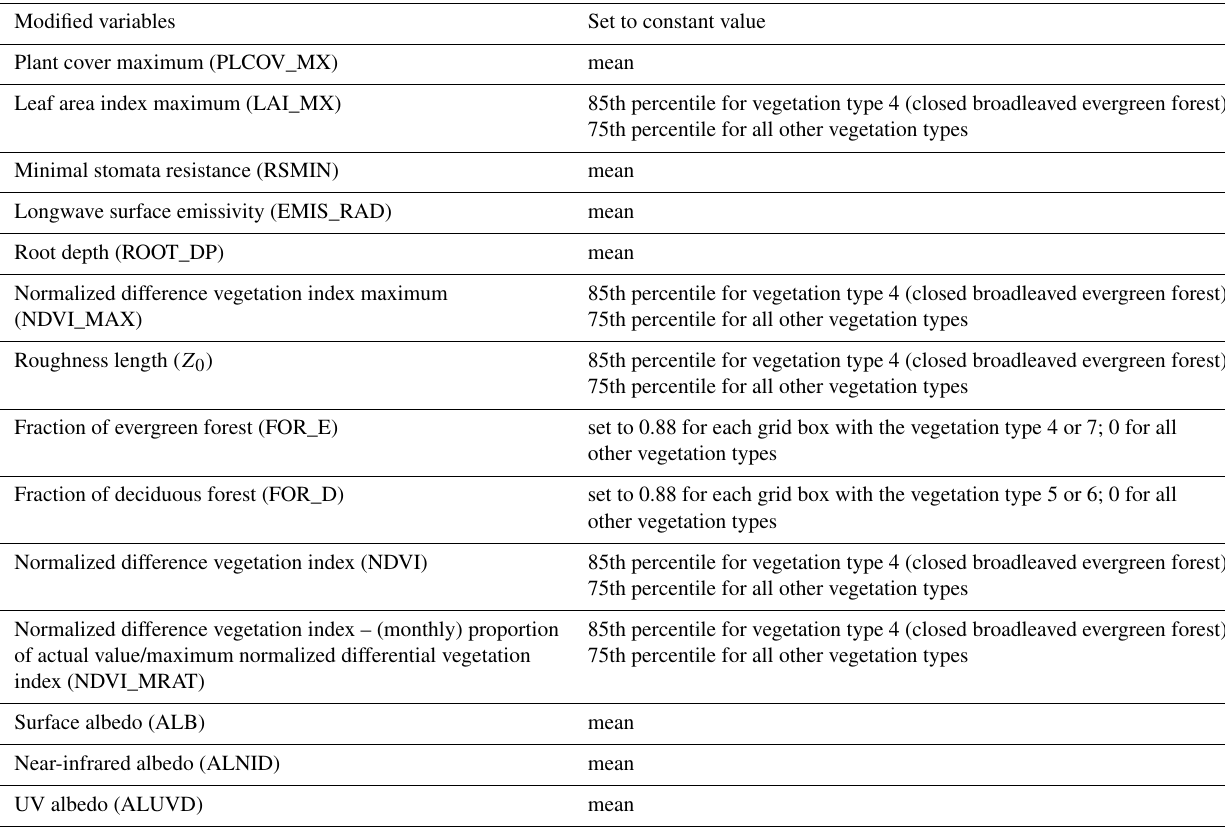
Table A2. Values prescribed for each variable and each vegetation type in the GS simulations. The values were calculated based on all grid points where a vegetation type is dominant. Variable names in brackets refer to the variable names in the external parameter file used in the simulations.